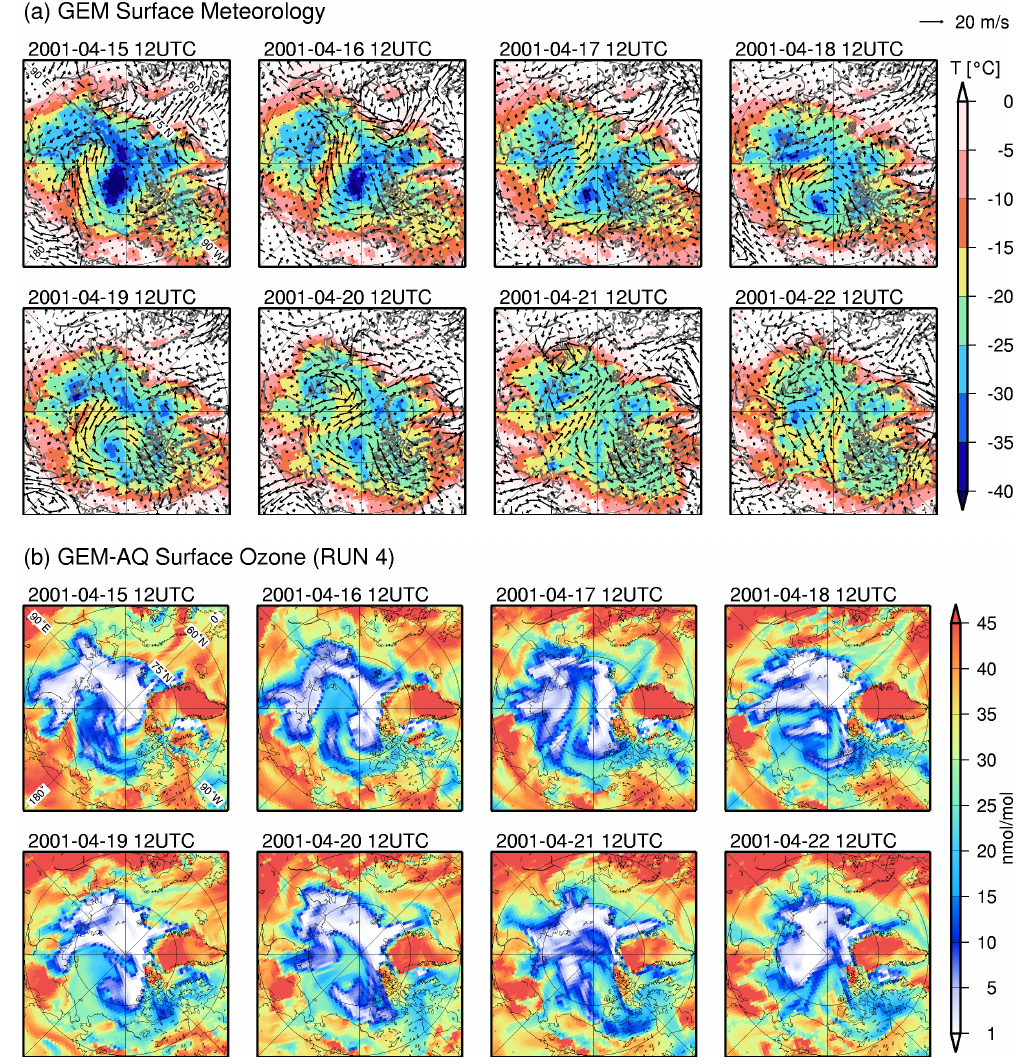
Fig. 9. (a) Surface air temperatures (color shade, in ◦ C) and wind vectors (arrow length for the wind speed of 20ms − 1 is indicated in the top right corner) at 12:00UTC each day between 15–22 April 2001 simulated by the model; and (b) The same as (a) but for surface ozone mixing ratios (in nmolmol − 1 ) simulated in Run